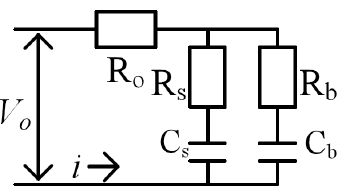
Figure 2. The battery RC